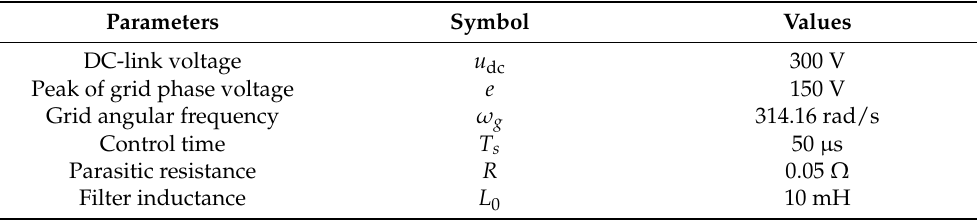
Figure 7. T-type three-level three-phase grid-connected inverter experimental platform. Table 2. System and control parameters.